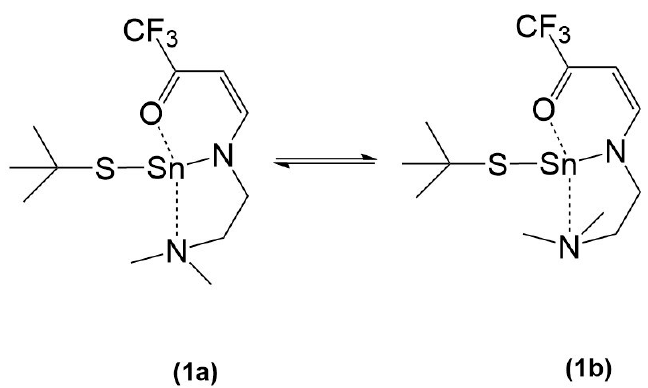
Figure 3. Proposed solution dynamics between two conformational isomers .